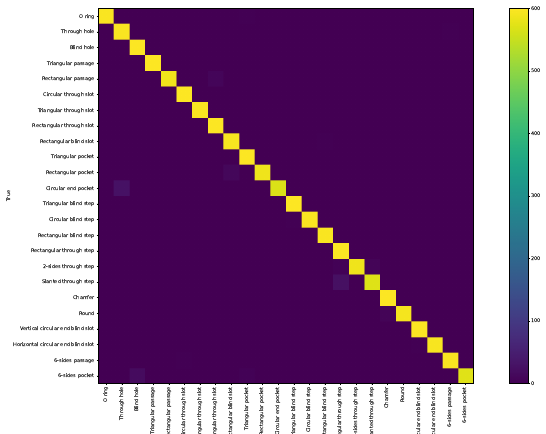
Figure A3. Confusion matrix for MsvNet [20].